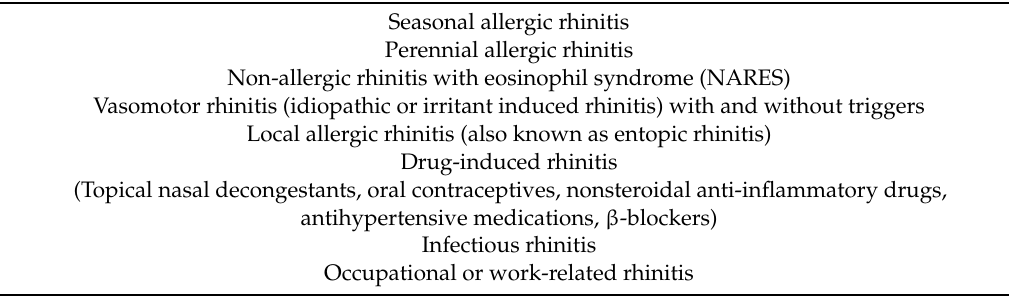
Table 1. Di ff erential diagnosis of chronic rhinitis *,